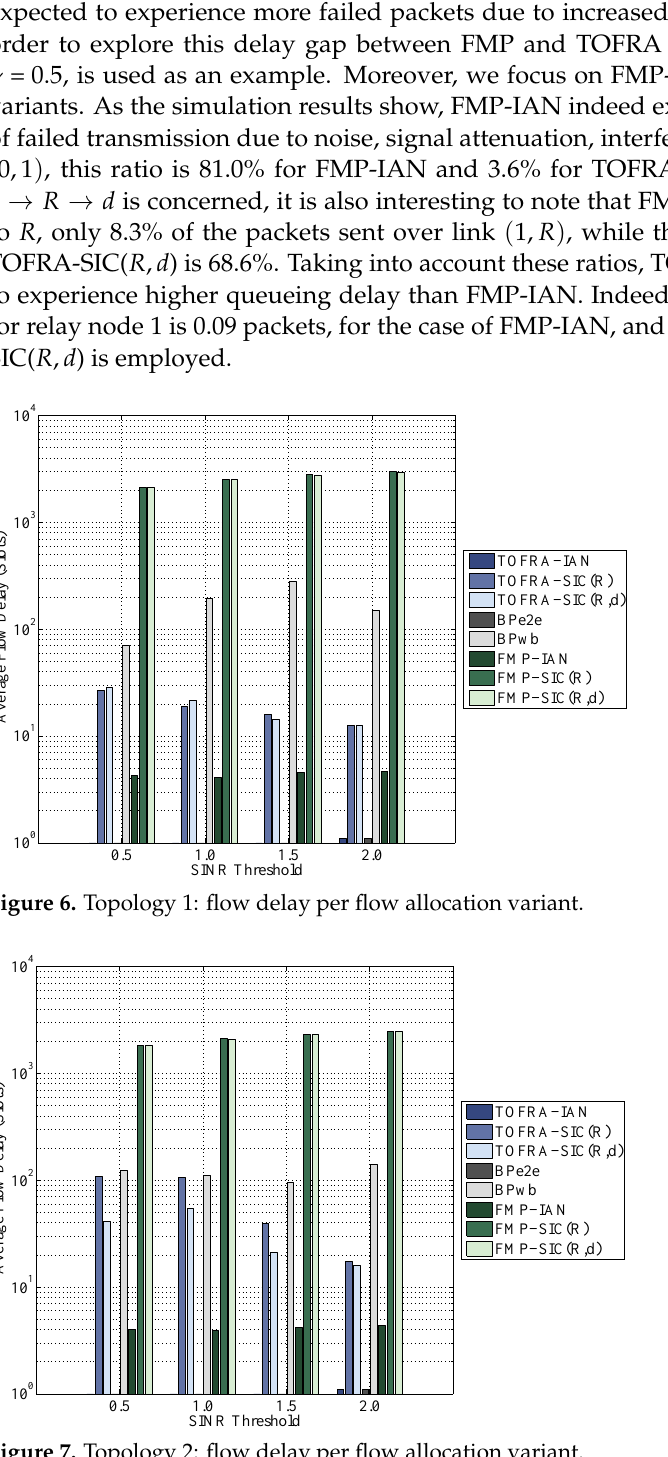
Figure 7. Topology 2: flow delay per flow allocation